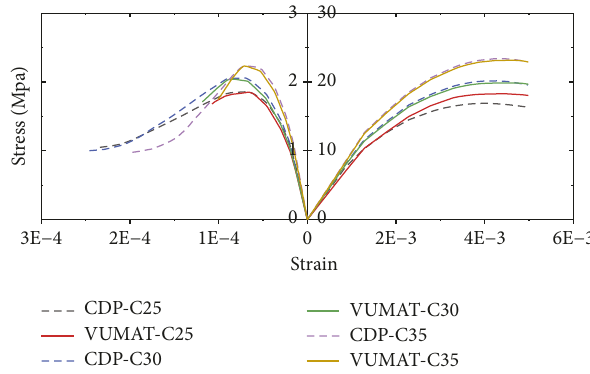
Figure 3: Mechanical